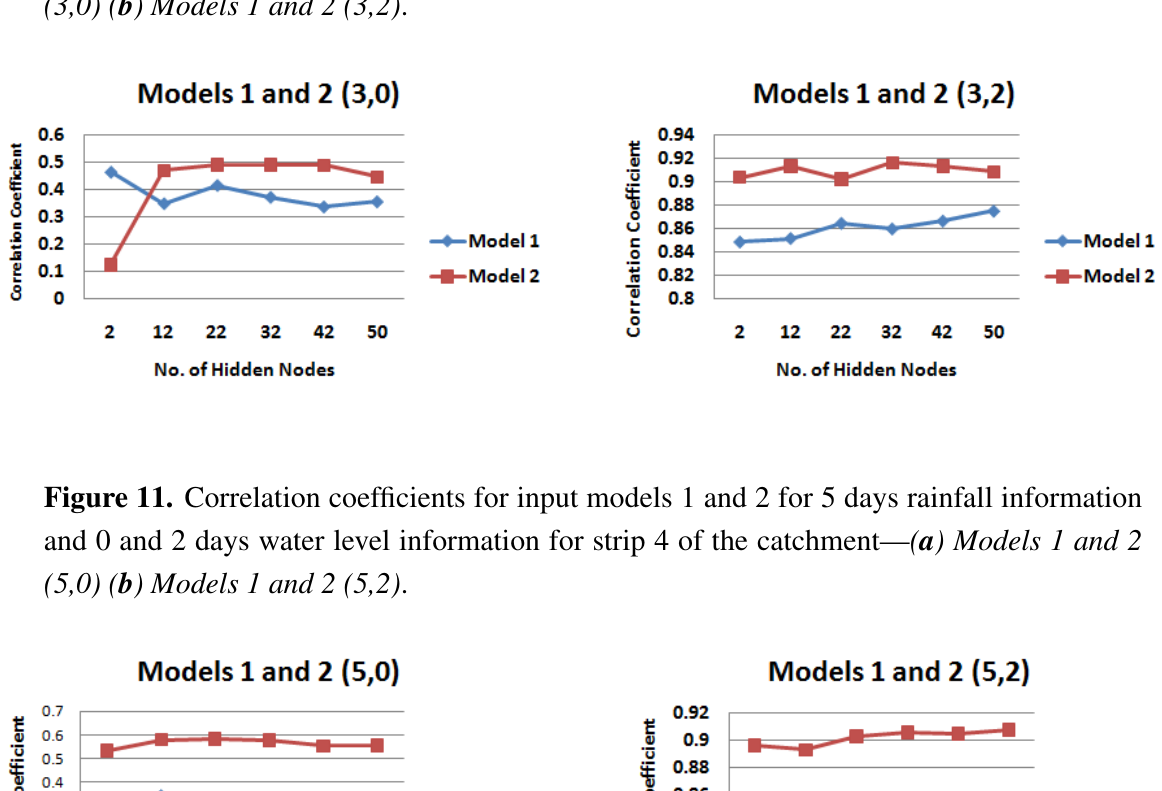
Figure 10. Correlation coefficients for input models 1 and 2 for 3 days rainfall information and 0 and 2 days water level information for strip 4 of the catchment— ( a ) Models 1 and 2 (3,0) ( b ) Models 1 and 2 (3,2) .